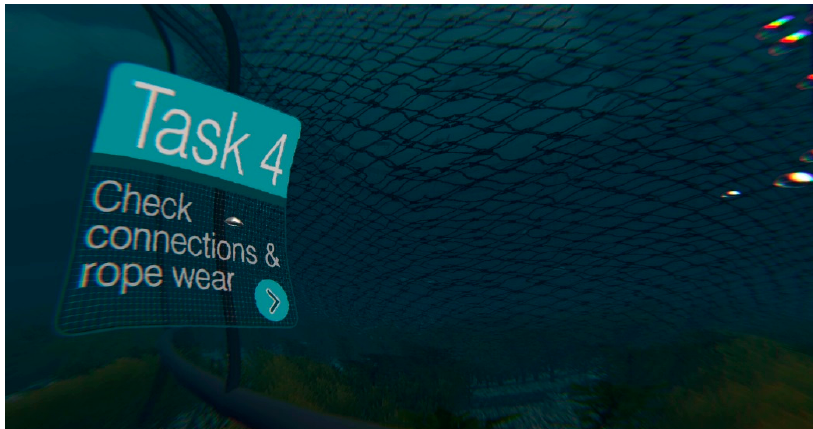
Figure 4 . Information panels that can be used to advise divers on what they should look out for.